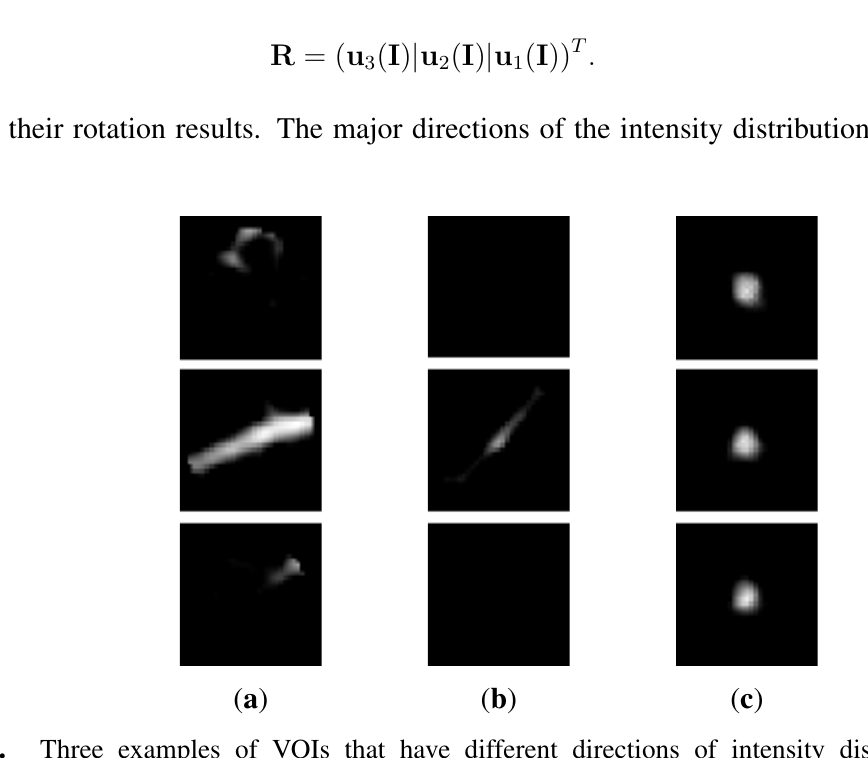
Figure 8. Three examples of VOIs that have different directions of intensity distributions. ( a ) example 1; ( b ) example 2; ( c ) example 3. The first, second and third rows represent the upper slices, the slices of interest, and the lower slices,